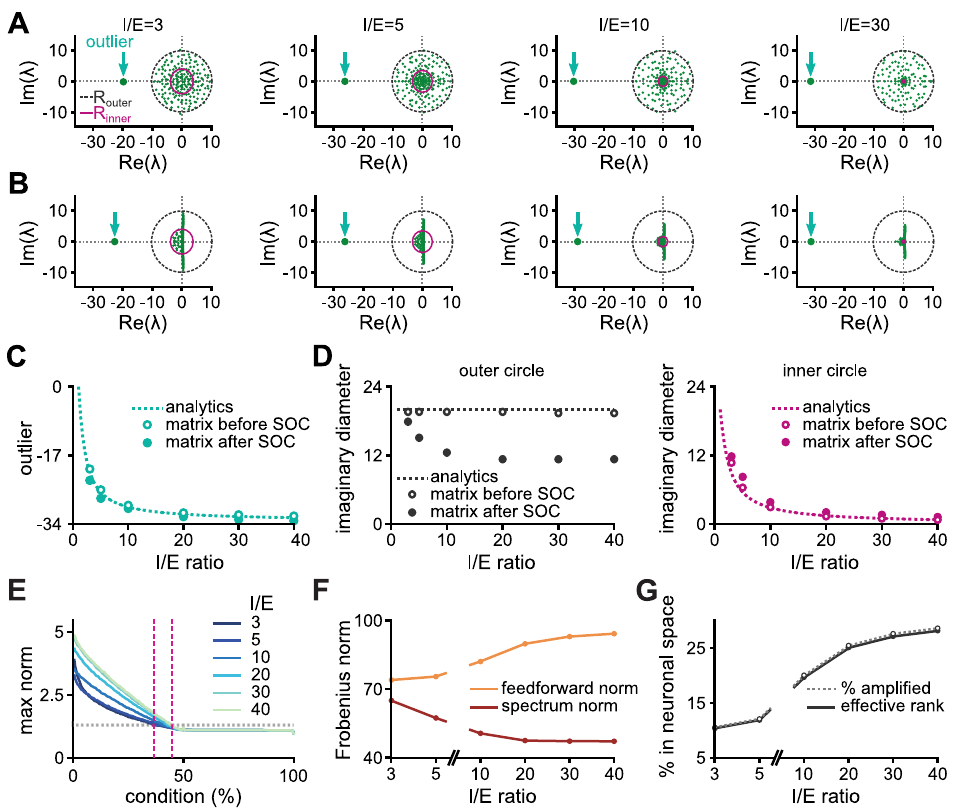
Fig 7. The effect of inhibitory dominance in Dalean matrices. A , Eigenspectra of connectivity matrices satisfying Dale’s law: 100 excitatory and 100 inhibitory neurons sparsely connected (probability of connection, p = 0.1) without self loops, constructed with spectrum of radius 10 and global inhibitory dominance of strength I / E (indicated on top of each panel). Outlier, outer radius ( R outer ), and inner circle ( R inner ) are highlighted. See Methods for details. B , Eigenspectra of connectivity matrices from panel A after optimising inhibitory weights with the SOC algorithm (see Methods for details). C , Value of the purely real outlier before (open circle) and after (closed circle) optimisation. Dashed line represents the analytical expression (Eq 9). Circles correspond to average over 1000 realisations. D , Imaginary diameter of the outer (left) and inner (right) circles. Open and closed circles represent average values before and after SOC optimisation algorithm, respectively, for 1000 random realisations. The outer and inner radii are calculated as the radius for which the density of imaginary elements drops below 0.005 and below half the maximum density, respectively. Dashed grey line (left) indicates d im = 20, and purple dashed line (right) represents the analytical expression (Eq 10). E , Maximum norm per initial condition for different I / E ratios. Grey dotted line corresponds to a response norm that is 50% larger than the norm of the initial condition. Pink dashed lines indicate the percentage of initial conditions that elicit transients with maximum norm larger than 50% for I / E = 3 (lower percentage) and I / E = 40 (higher percentage). We linearly scale all weights to keep the same Frobenius norm (equal to 100) for comparison. F , The spectrum and the feedforward norms for different values of I / E in the corresponding real Schur transformation. G , Percentage of amplified conditions and effective rank of the corresponding matrix P (defined in the text) in the linear